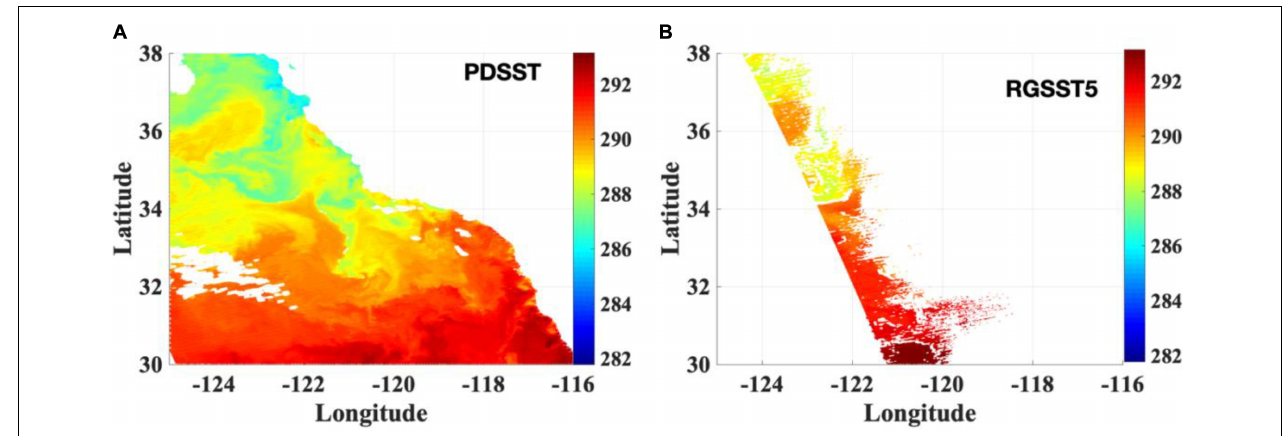
FIGURE 4 | Comparison of daytime SST retrieval maps of a subset of area 9 ◦ by 8 ◦ from a granule of MODIS-AQUA for the California coast: (A) PDSST and (B) RGSST5. The ranges of longitude and latitude from − 180 ◦ to 180 ◦ and from − 90 ◦ to 90 ◦ represent West to East and South to North, respectively. Unit of color bar is